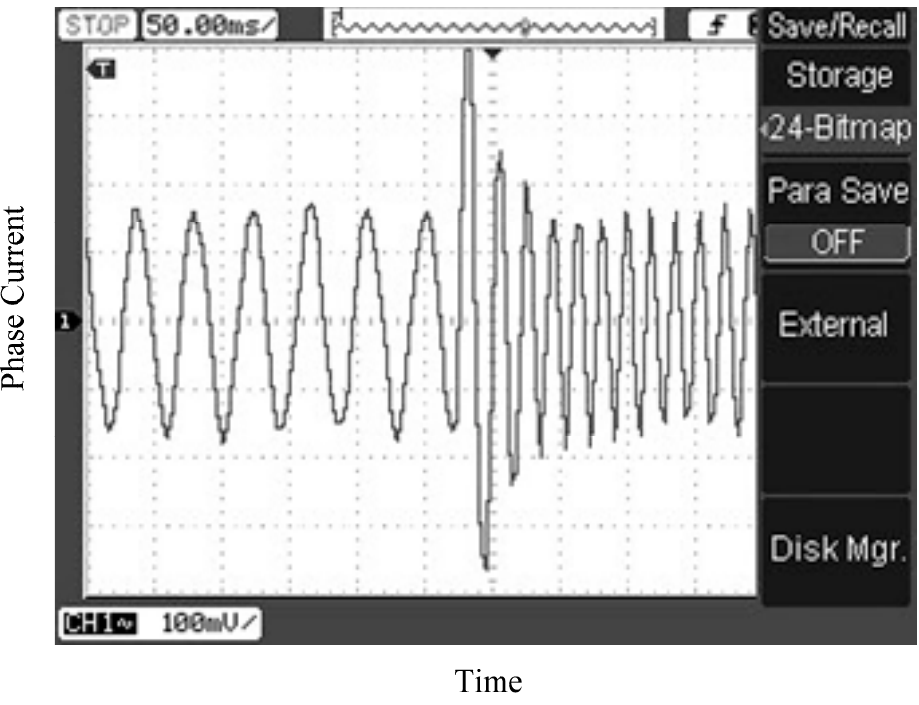
Figure 16. Current of phase ( a ) at reference speeds of 0.2 pu to 0.4 pu.